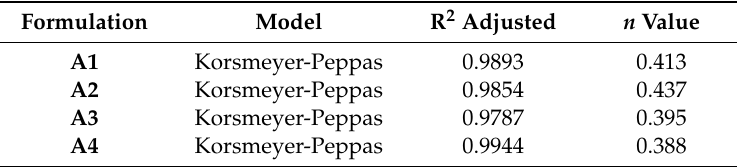
Table 7. ATH drug release